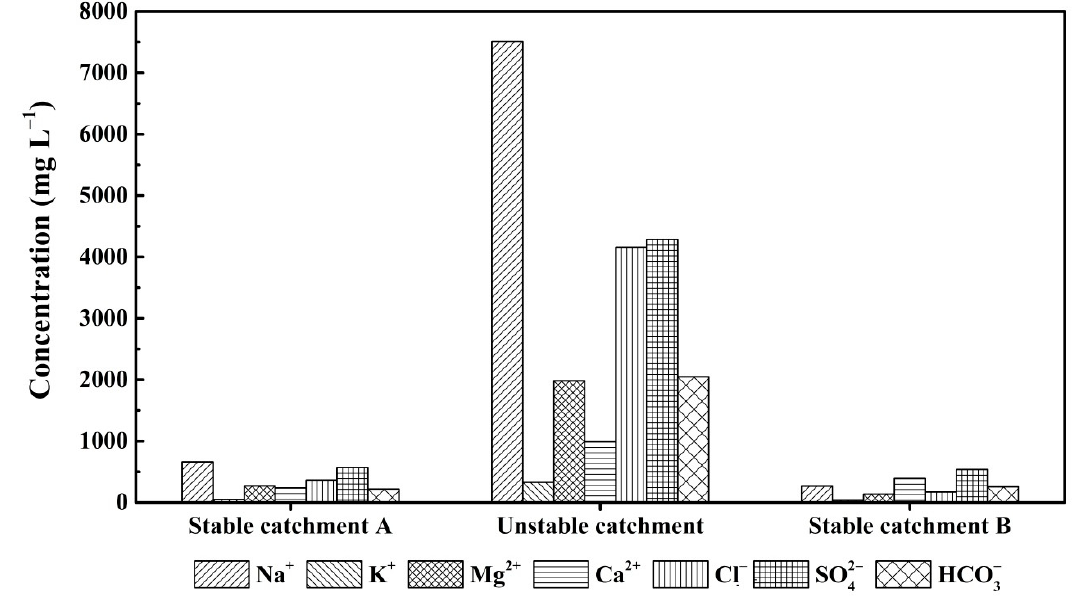
Figure 4. Spatial distribution of ion concentration in Qingtu Lake.